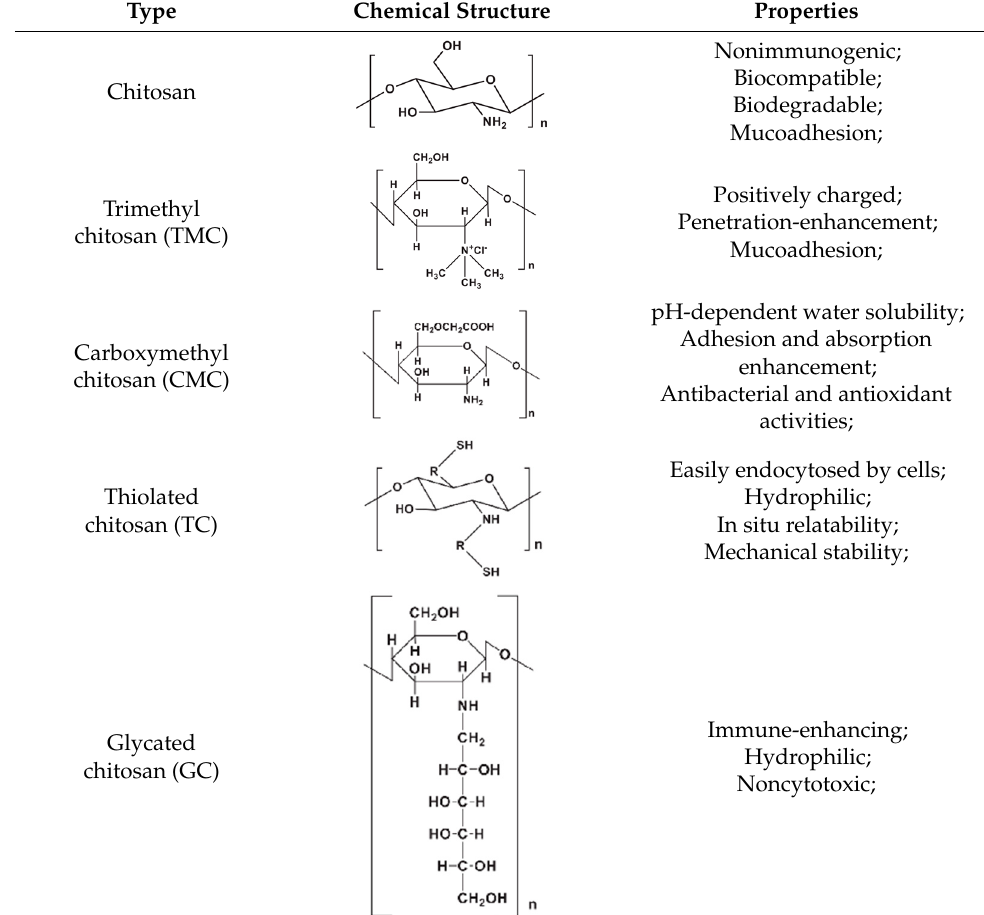
Table 2. The structures of chitosan and its properties.